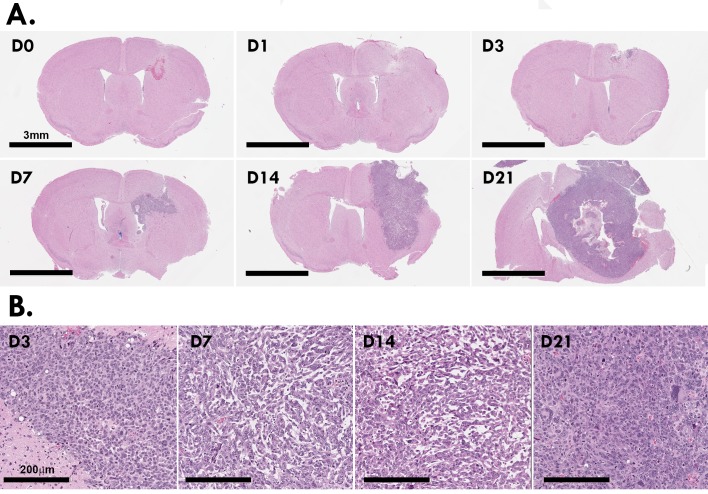
Histopathology of Gl261 gliomas.Four μm paraffin sections of murine Gl261 brain tumors stained with hematoxylin and eosin Y/eythrosin (A). High resolution of morphology of the Gl261 cells as the tumor grows and matures (B). Images are representative of N = 12 mice per time point.